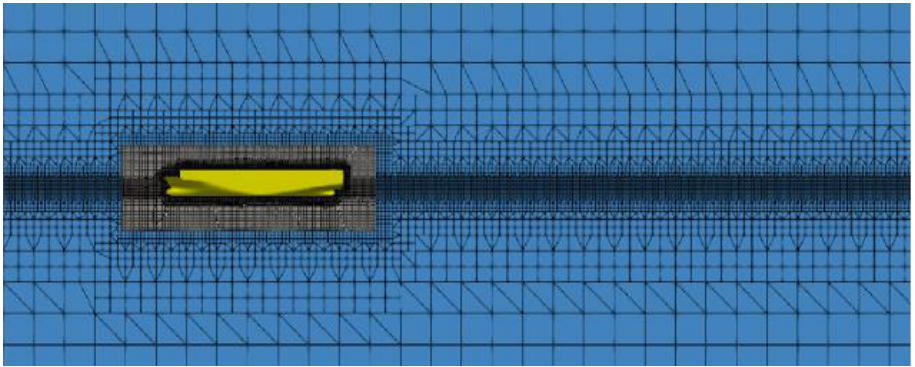
Figure 13. CFD computational domain with refinements.